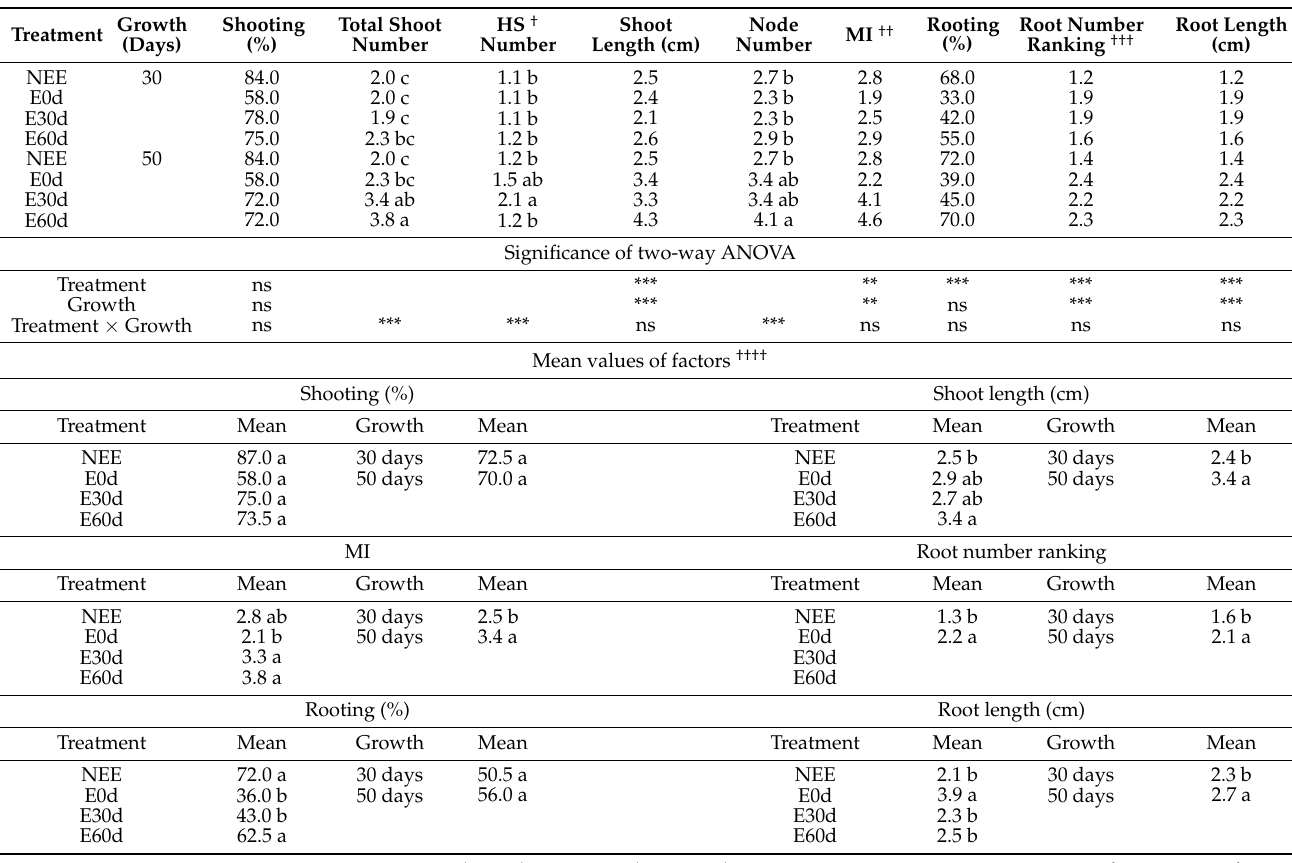
Table 4. Shoot regeneration of non-encapsulated (NEE) and encapsulated nodal explants when cultured on hormone-free Murashige and Skoog media, after 0, 30, and 60 days’ storage of the beads (E0d, E30d, and E60d, respectively) at 5 ◦ C, and cultured for 30 or 50 days on media at 25 ◦ C.